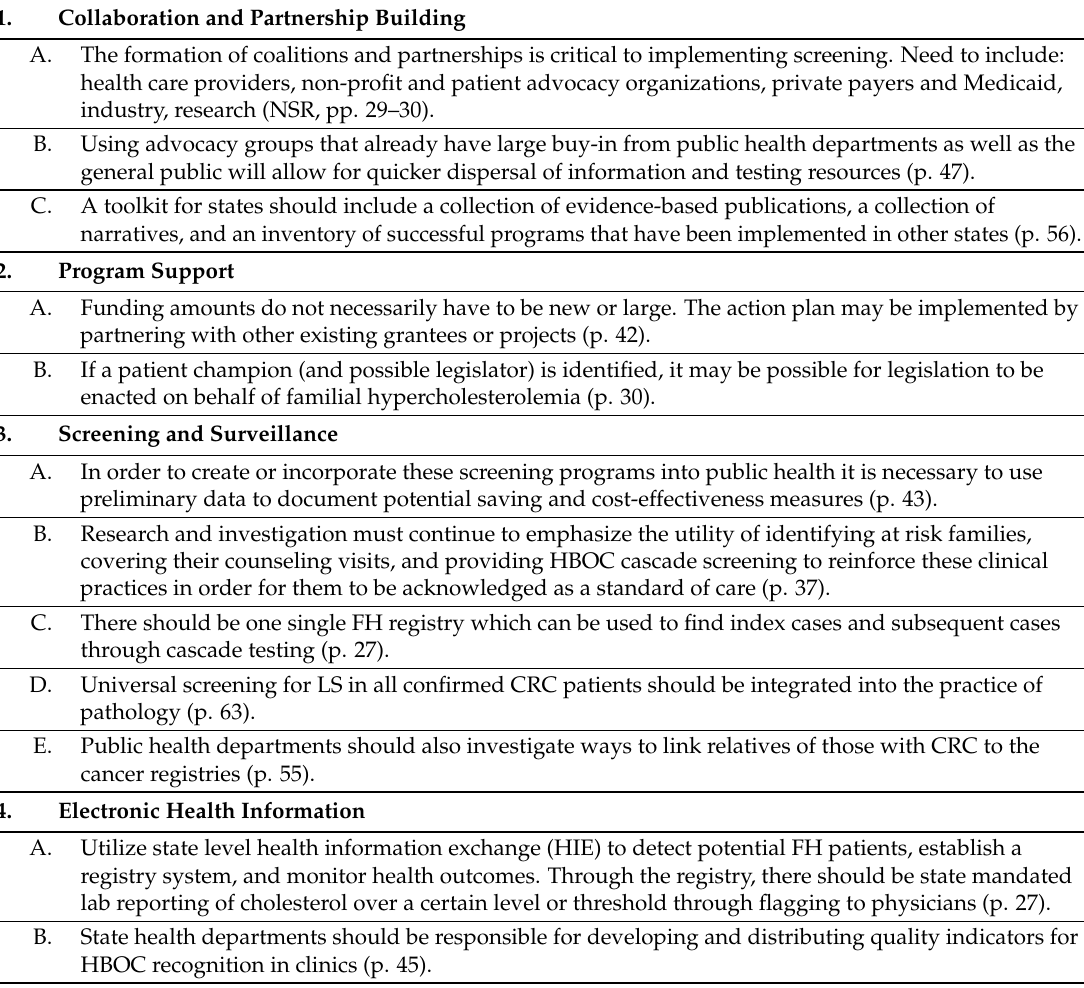
Table 2. Select New Strategies report